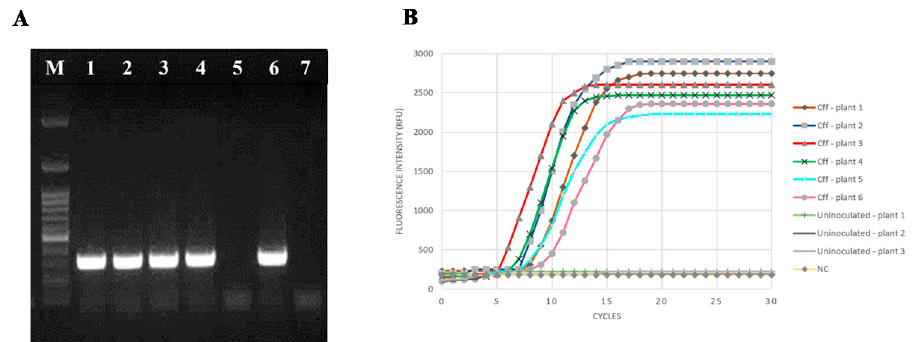
Figure 3. LAMP assay results from C ff -artificially infected bean plants cv. Cannellino. The C ff type strain ICMP 2584 was used for artificial inoculation. ( A ) C ff infection was confirmed by conventional PCR carried out using the primer pair C ff FOR2 / C ff REV4. Lanes: 1, 2, 3, 4: C ff -inoculated bean plants; 5: uninoculated bean plant; 6: C ff ICMP 2584 T pure DNA; 7: negative control, sterilized molecular grade water as a template; M - Gene Ruler 100 pb Plus DNA Ladder. ( B ) Real-time monitoring of LAMP reaction for C ff detection on bean plants artificially inoculated with C ff ICMP 2584 T or with SPS. Sterilized molecular grade water was used as a negative control (NC).